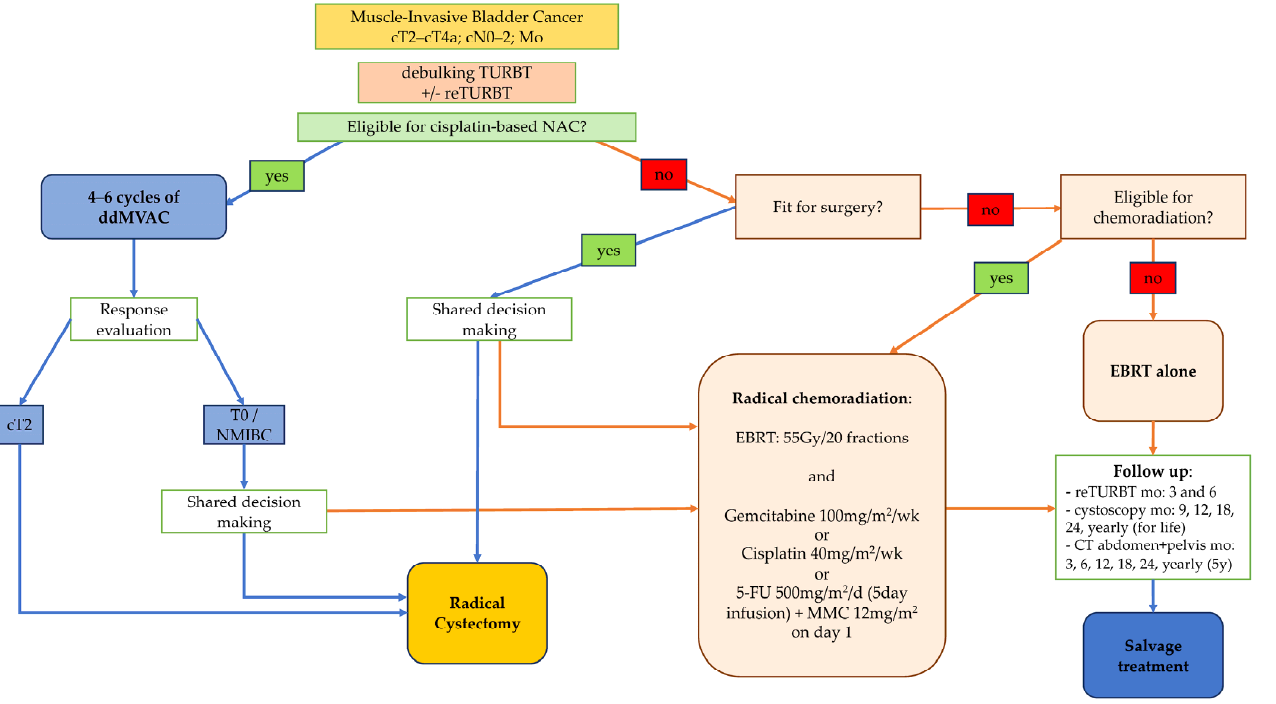
Figure 1. Flowchart illustrating the proposed treatment planning process in patients with muscle- invasive bladder cancer, incorporating CMT. CT: computed tomography; ddMVAC: dose-dense methotrexate, vinblastine, doxorubicin, cisplatin; EBRT: external beam radiation therapy; NAC: neoad- juvant chemotherapy; NMIBC: non-muscle-invasive bladder cancer; TURBT: transurethral resection of bladder